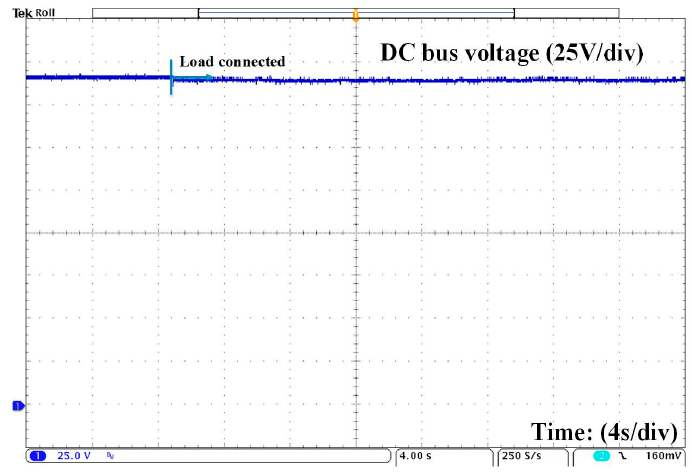
Figure 17. LED-type lamp connection.